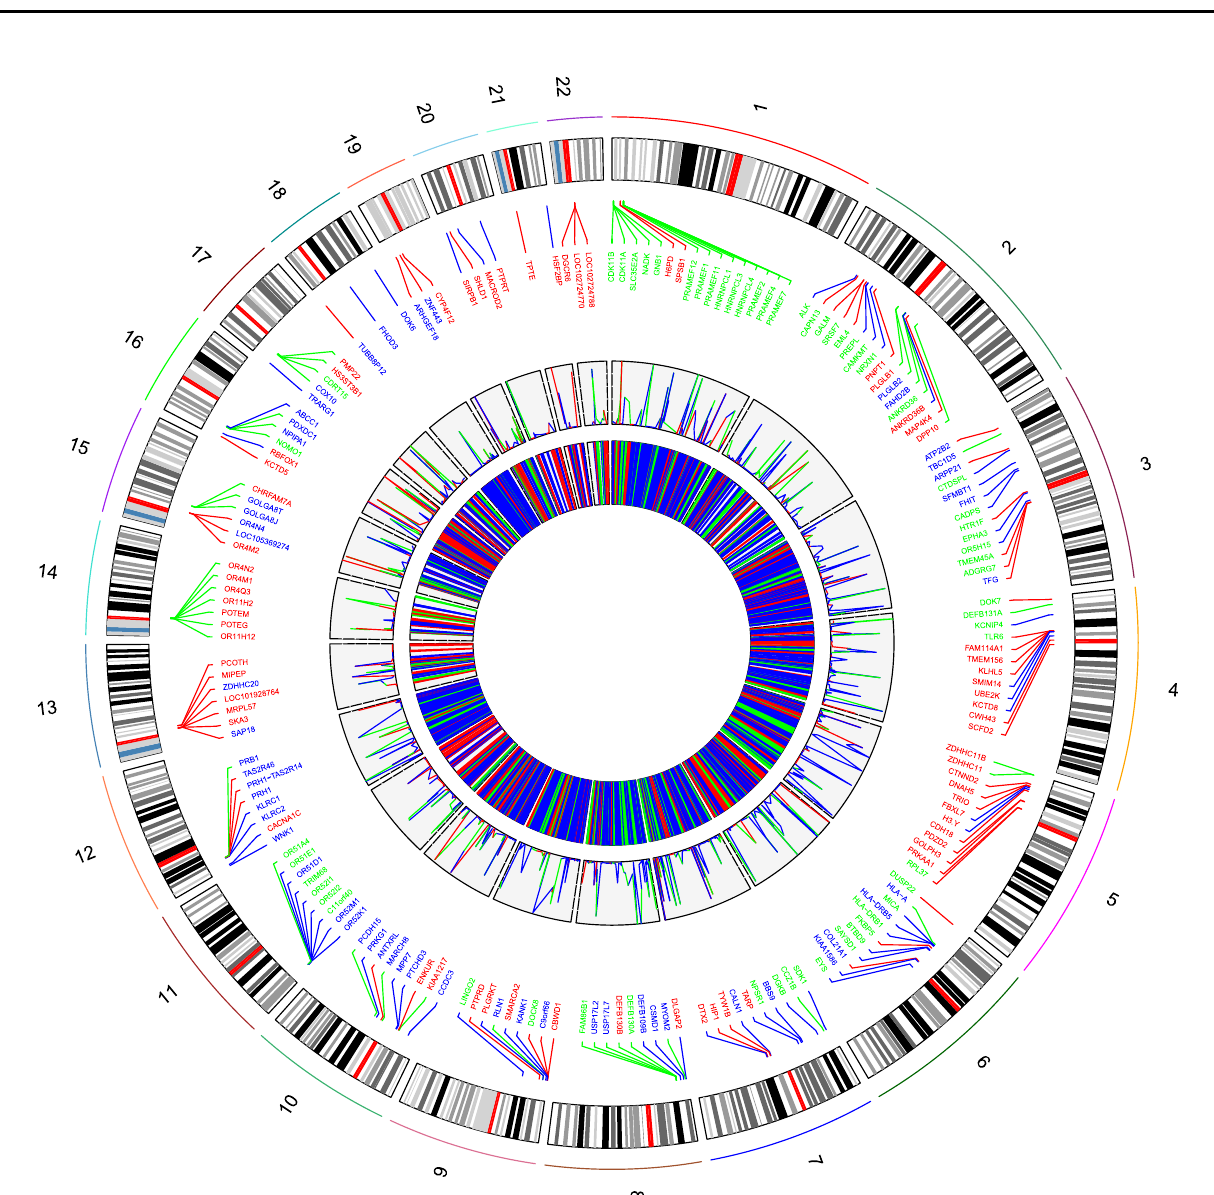
Fig. 3 Circular plot showing a chromosomal view of the global CNV map of the Tunisian population. The innermost circle with vertical lines represents all the CNV from chromosomes 1 to 22: blue, red, and green color lines represent deletions, duplications, and mixed loci, respectively. The frequency of each CNV is depicted by the second track. The third concentric circle represents the genomic distribution of CNV genes overlapped according to the type of the